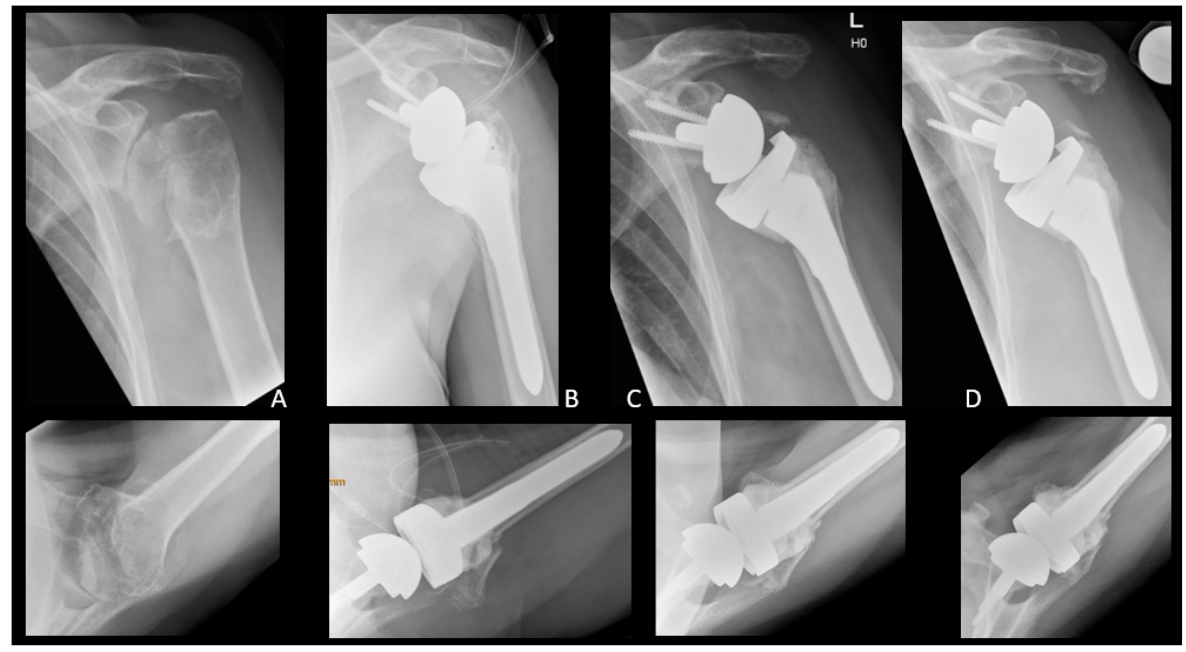
Figure 2. Surgical treatment of a postoperative GTF with FiberWire suture cerclage. Left shoulder, X-rays in a.p. and axial views. ( A ) Preoperative arthritis after humeral head fracture. ( B ) Intraoperative control of RTSA. ( C ) Greater Tuberosity fracture. ( D ) Greater Tuberosity after surgical suture cerclage, unconsolidated, but with no further dislocation.